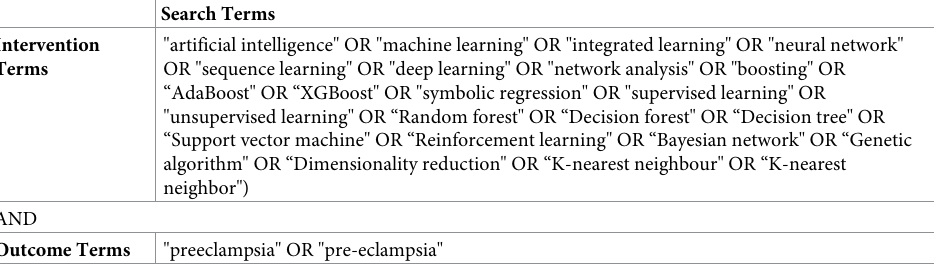
Table 2. List of search terms to be applied covering the AI/ML intervention terms and PE outcome